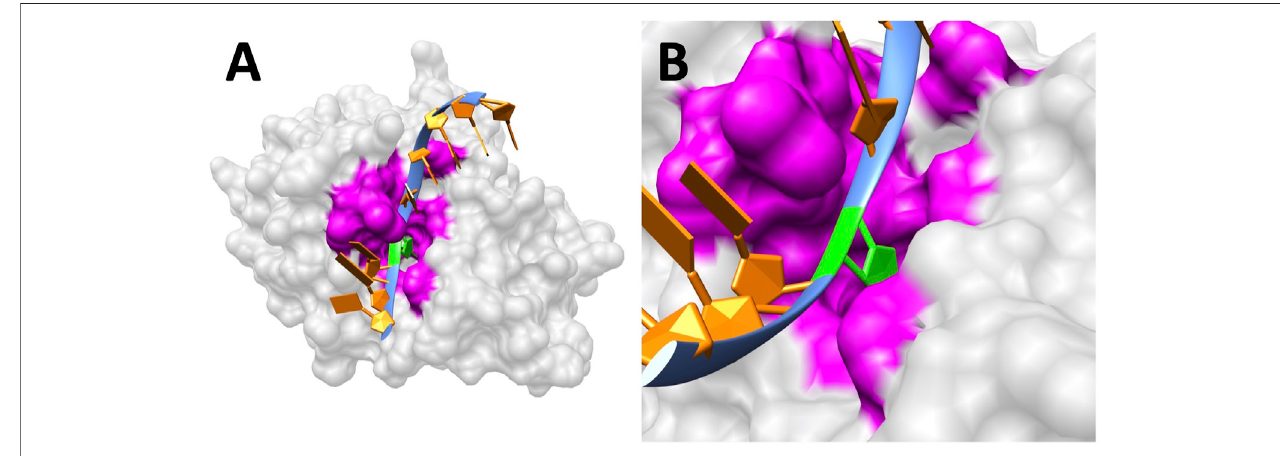
FIGURE3| UDGbindingpocket. (A) ThesurfaceofUDGwiththepocketcoloredinmagenta.TheB5baseuracil(green) fl ipsouttothepocket. (B) Acloseupofthe binding pocket (magenta) surface and the uracil base (green).